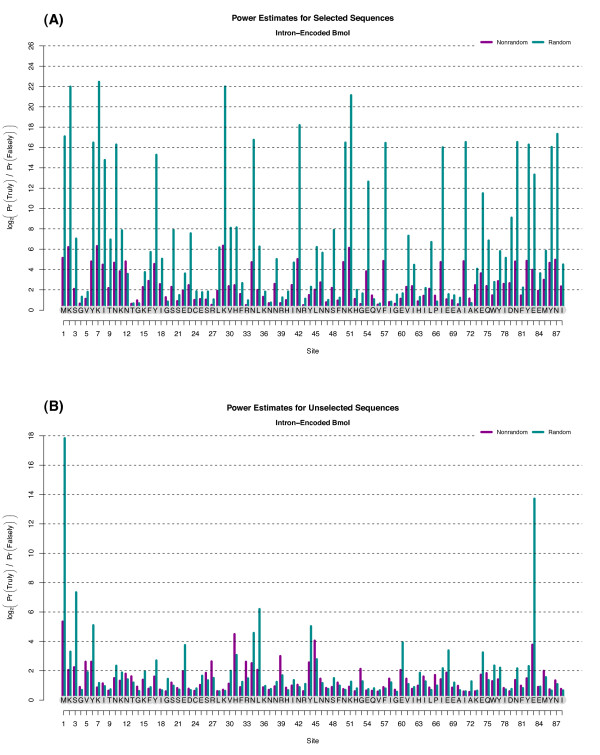
The Reliability of Inference for I-BmoI. Estimates of statistical power (reliability of inference) for I-Bmol, for both selected and unselected clone populations. 'Nonrandom' associations are presumed due to the alternate hypothesis while 'random' associations are presumed due to the null. Power is computed as the expected log2-odds-ratio for either true-positive versus false-negative (mauve) or true-negative versus false-positive (teal). (A) For the selected sequences, the true-positive ratio is strongly correlated with the posterior log2-odds-ratio shown in Figure 1. (B) Approximate inferential power of sites in the unselected population, each of which is expected a priori to be near zero. Note that both M1 and E83, identified as putative outliers in Figure 1, are shown to clearly (and unexpectedly) violate the null hypothesis. Such violations hallmark systematic errors or experimental artifacts.